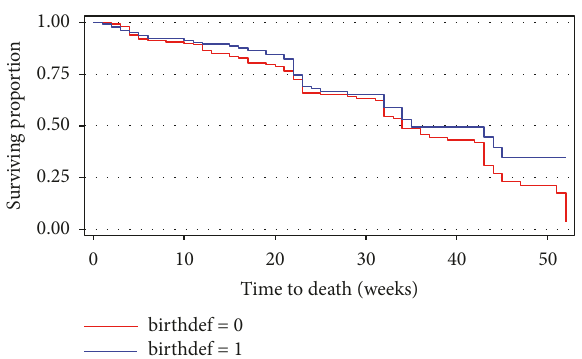
Figure 1: Kaplan-Meier curve showing surviving proportion of the infants with birth defect (birth defect = 1) and infants without birth defect (birth defect =